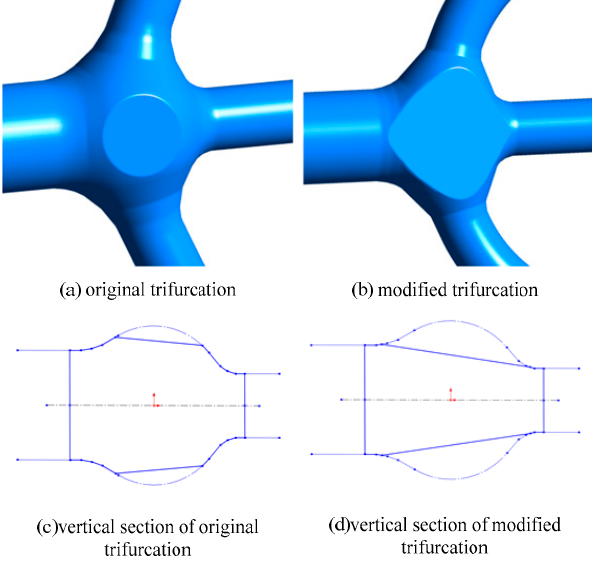
Figure 11. Comparison of the original and modified trifurcations.